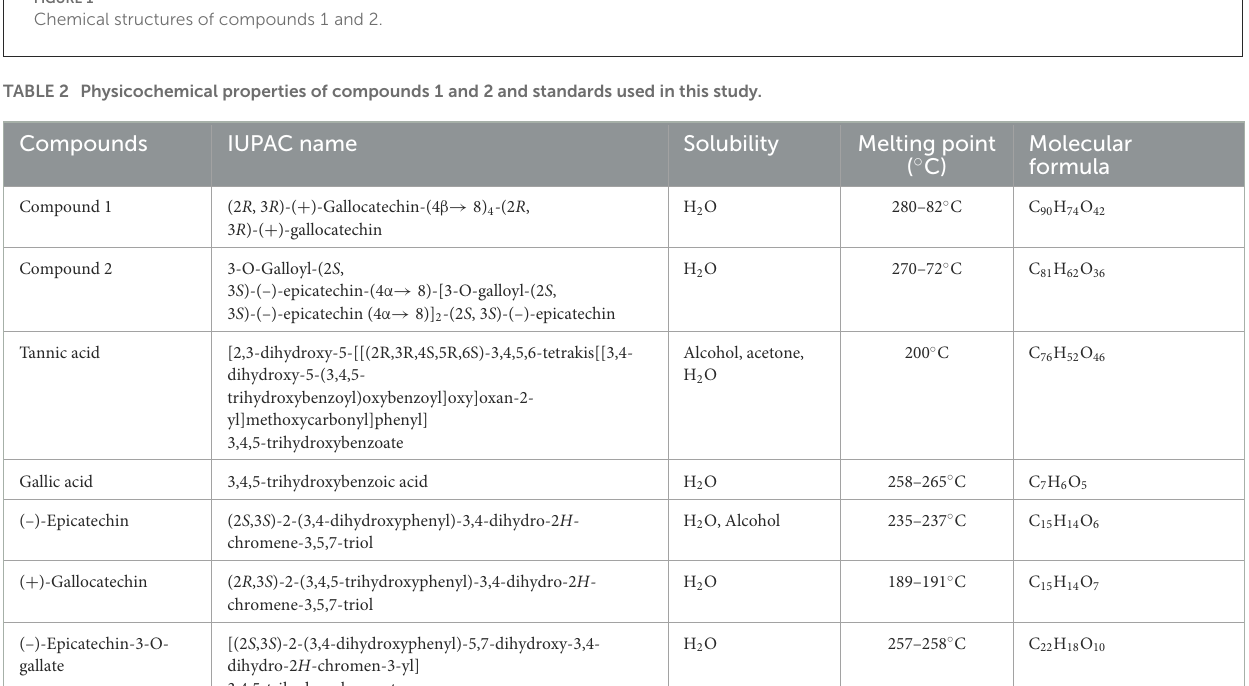
FIGURE1 Chemical structures of compounds 1 and 2.